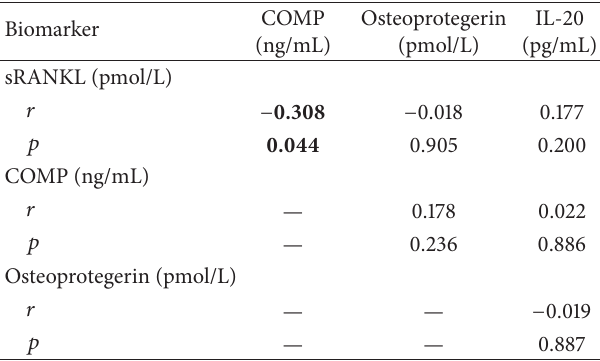
Table 6: Mutual correlation coefficients between the biomarkers serum concentrations in the psoriatic